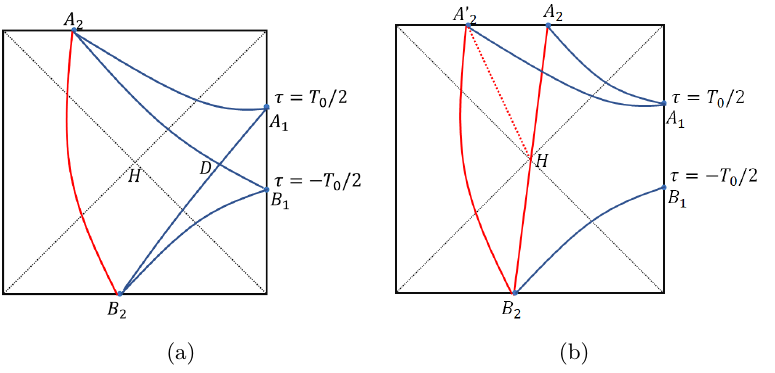
Figure 9 . The configurations of CWES of time-like interval in BTZ black hole. The blue curves stand for space-like geodesics and red curves stand for time-like geodesics. Panel a: there are two types of relevant configurations of CWESs, which are A 1 A 2 B 2 B 1 and A 1 B 2 A 2 B 1 . Panel b: the time-like geodesic A 2 B 2 passes through the bifurcated “point” of event